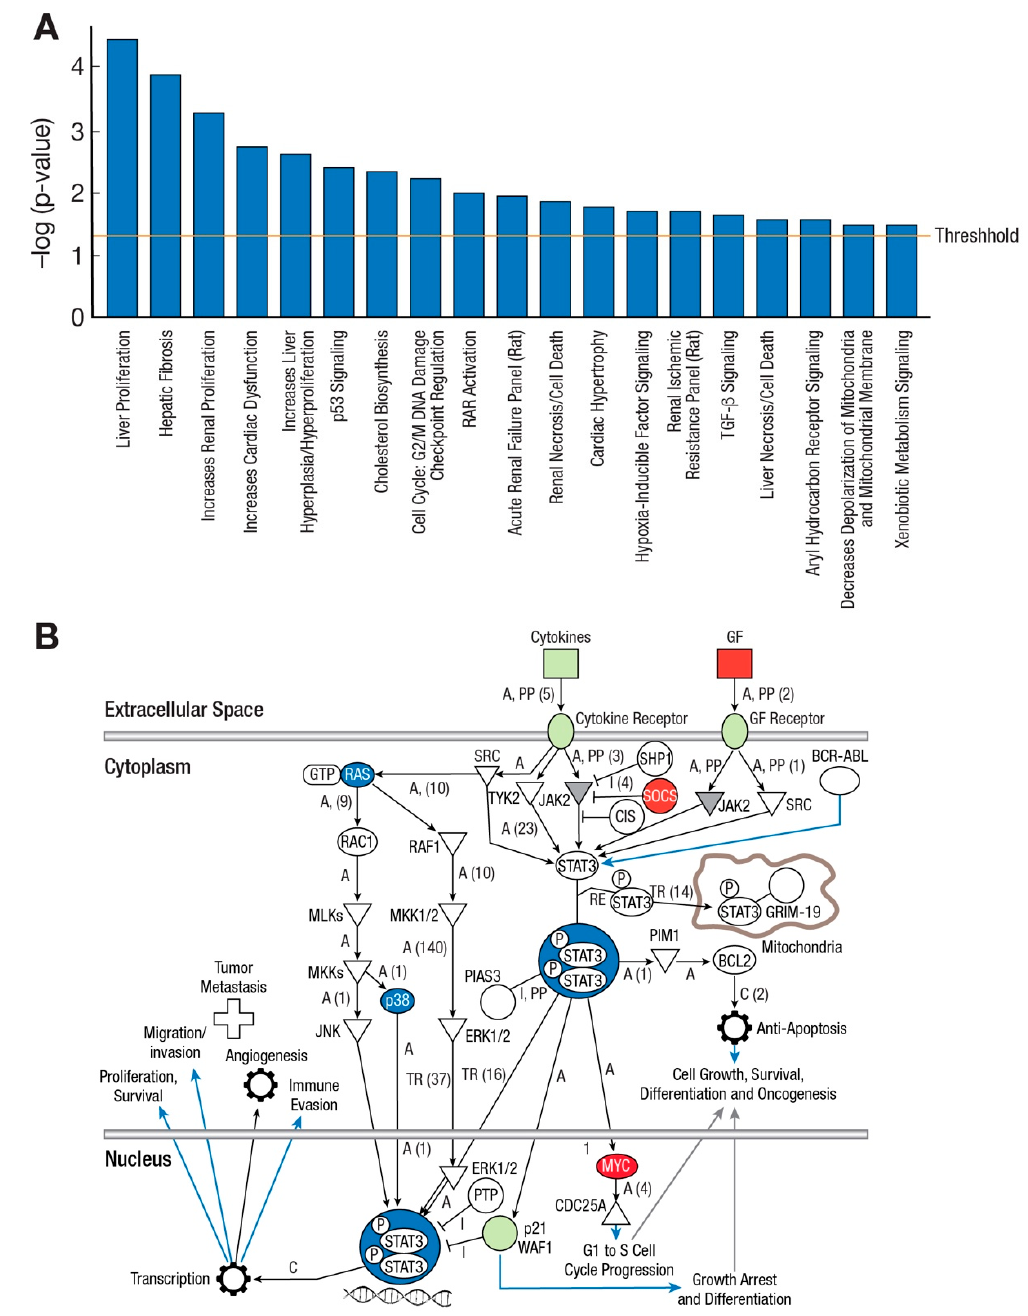
Figure 5. Canonical pathways and examples of gene upregulation in LADR cells. ( A ) Top canonical pathways for LADR cells compared with LAD2 cells, and ( B ) Suppressor of cytokine signaling (SOCS) genes are upregulated, which may contribute to an LADR cell inherent JAK2/STAT3 downregulation advantage. Upregulation of the viral oncogene MYC may provide an independent reason for cell proliferation, survival, and differentiation. Upregulated genes are highlighted in red. Black arrows designate pathways of interaction between signal transduction elements, blue arrows designate pathways of particular interest in the use of this cell line, T-arrow refers to inhibition.